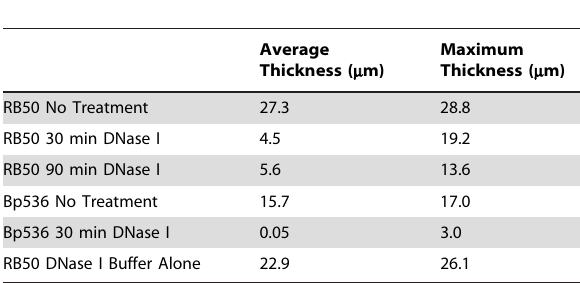
Table 1. COMSTAT analysis of statically grown Bordetella biofilms treated with DNase